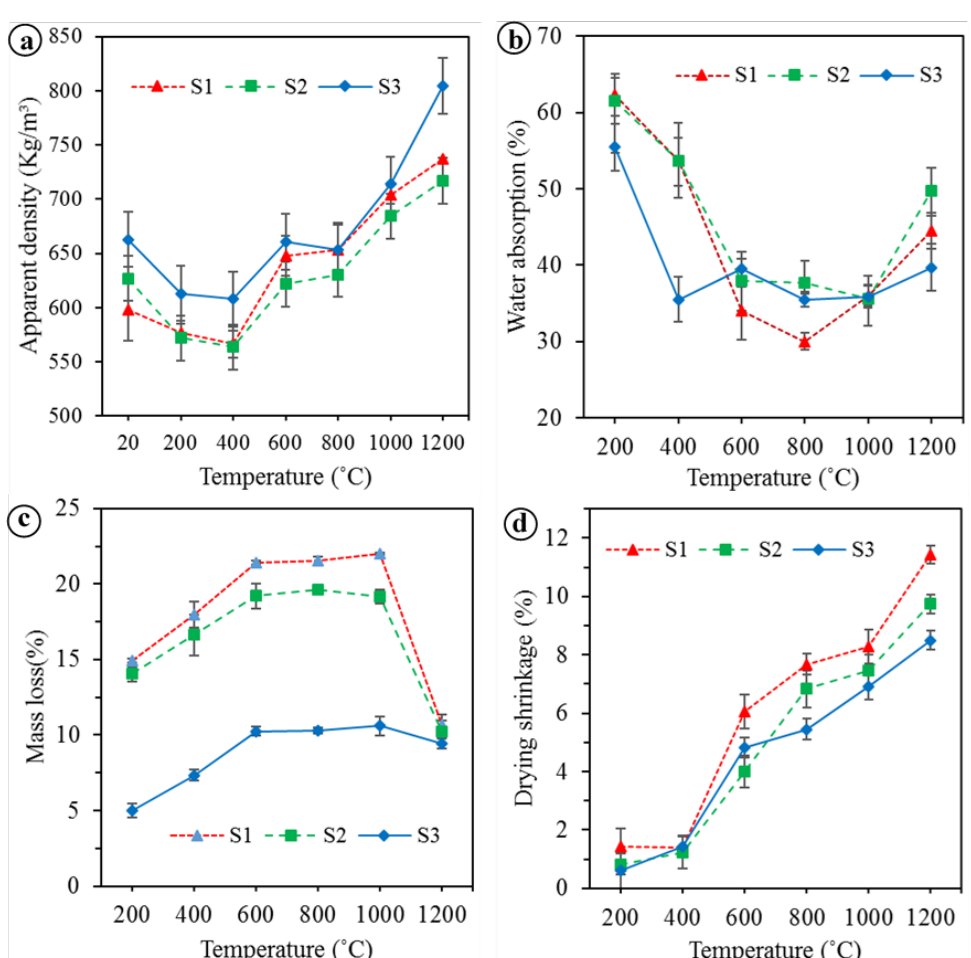
Figure 4. The physical properties of the BGFs at different temperatures: ( a ) apparent density, ( b ) water absorption, ( c ) mass loss, and ( d ) drying shrinkage.